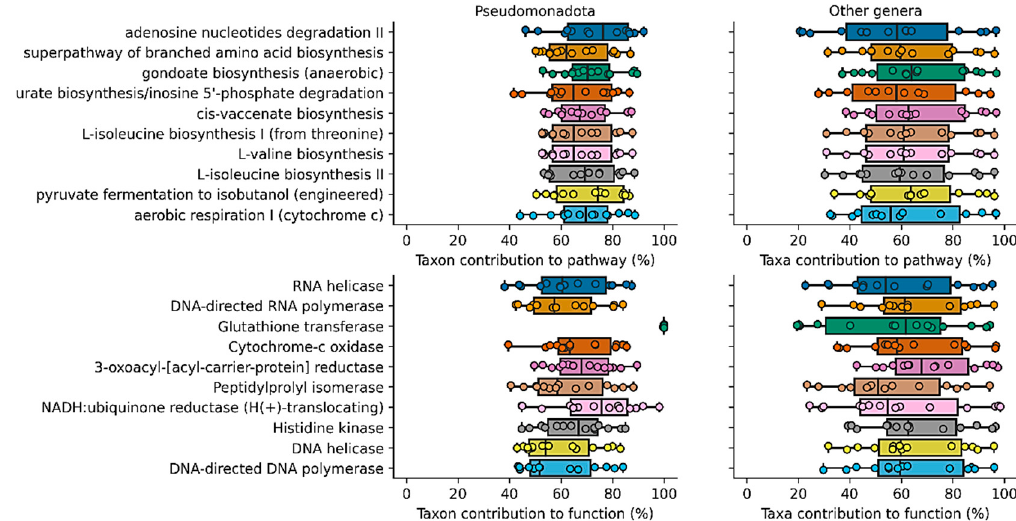
Figure 4. Contribution of the most abundant phylum and contribution of other genera than Massilia, Pedobacter , Pseudomonas , Sphingomonas , Suttonella and Verticia to each metabolic pathway and function per sample. Proteobacteria contributes more than 20% to each pathway and more than 40% to each function. In the case of genera, “others” contribute more than 20% to each pathway and function per sample.